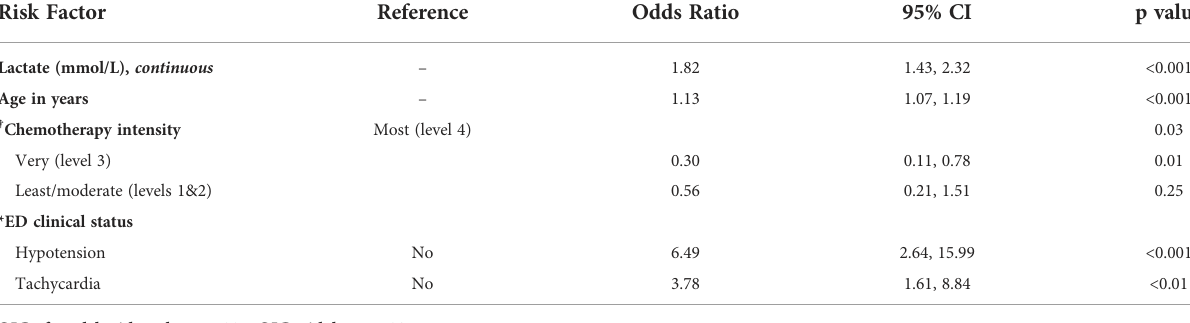
TABLE 2 Occurrence of ≥ 1 clinical deterioration event (CDE) within 48 hours, adjusted odds by risk factor (results of multivariable analysis). Risk